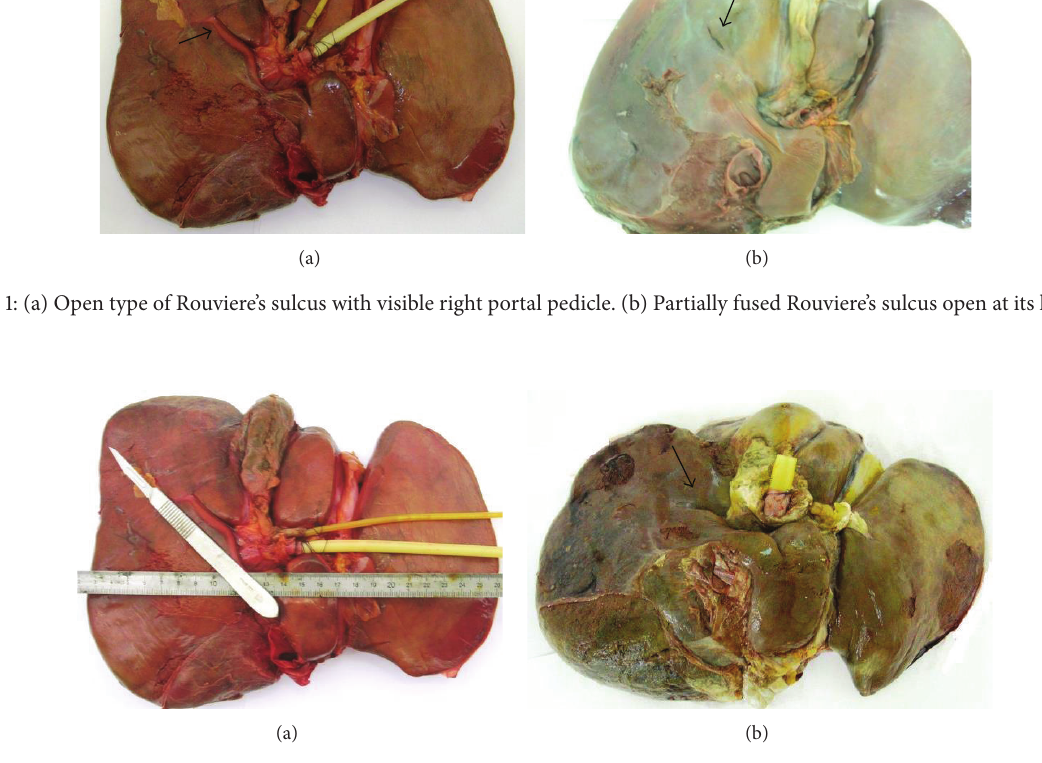
Figure 2: (a) Oblique type of Rouviere’s sulcus. (b) Horizontal type of Rouviere’s